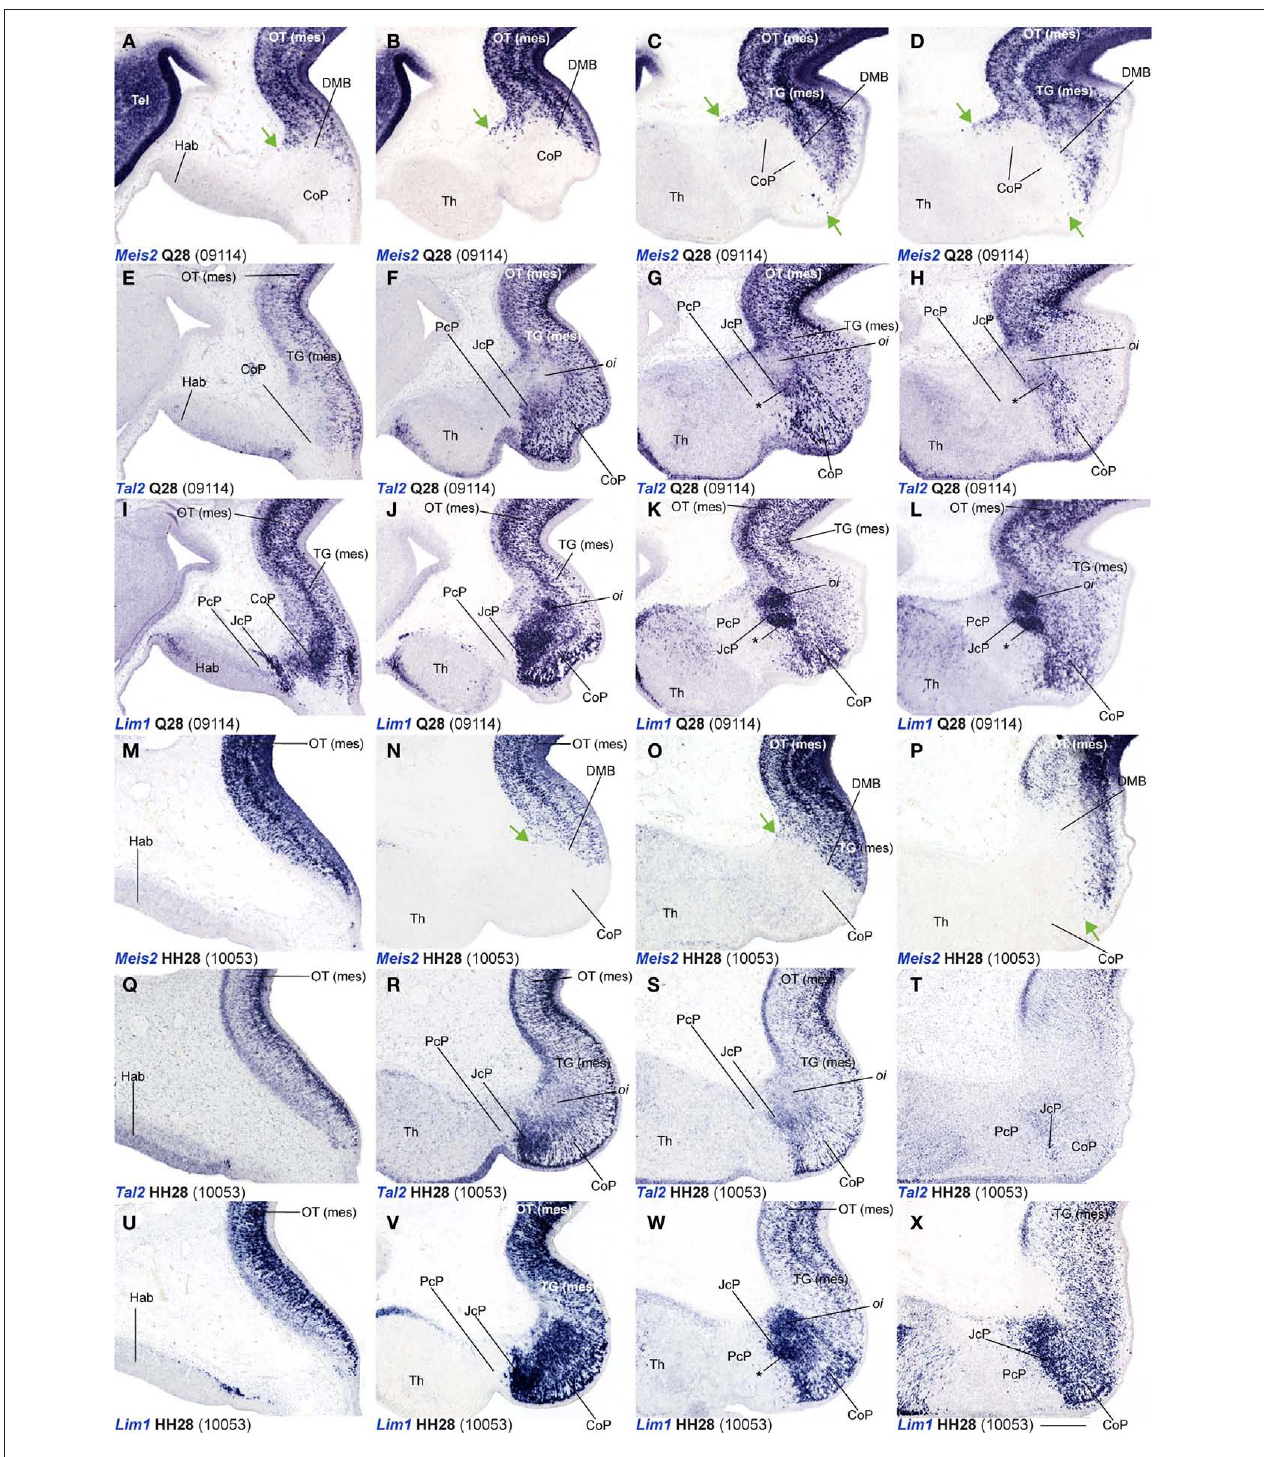
panels taken long the vertical columns represent essentially the same section level and are comparable across the species. Green arrows in (A–D,N–P) indicate apparently ectopic cells expressing Meis2 (midbrain marker) at the CoP su and pe strata. Asterisks in (G,H,K,L,W) identify the developing lateral spiriform nucleus, exhibiting high expression levels of Lim1 and a low Tal2 signal. Numbers between brackets: code of the specimen in our collection. Scale bar =